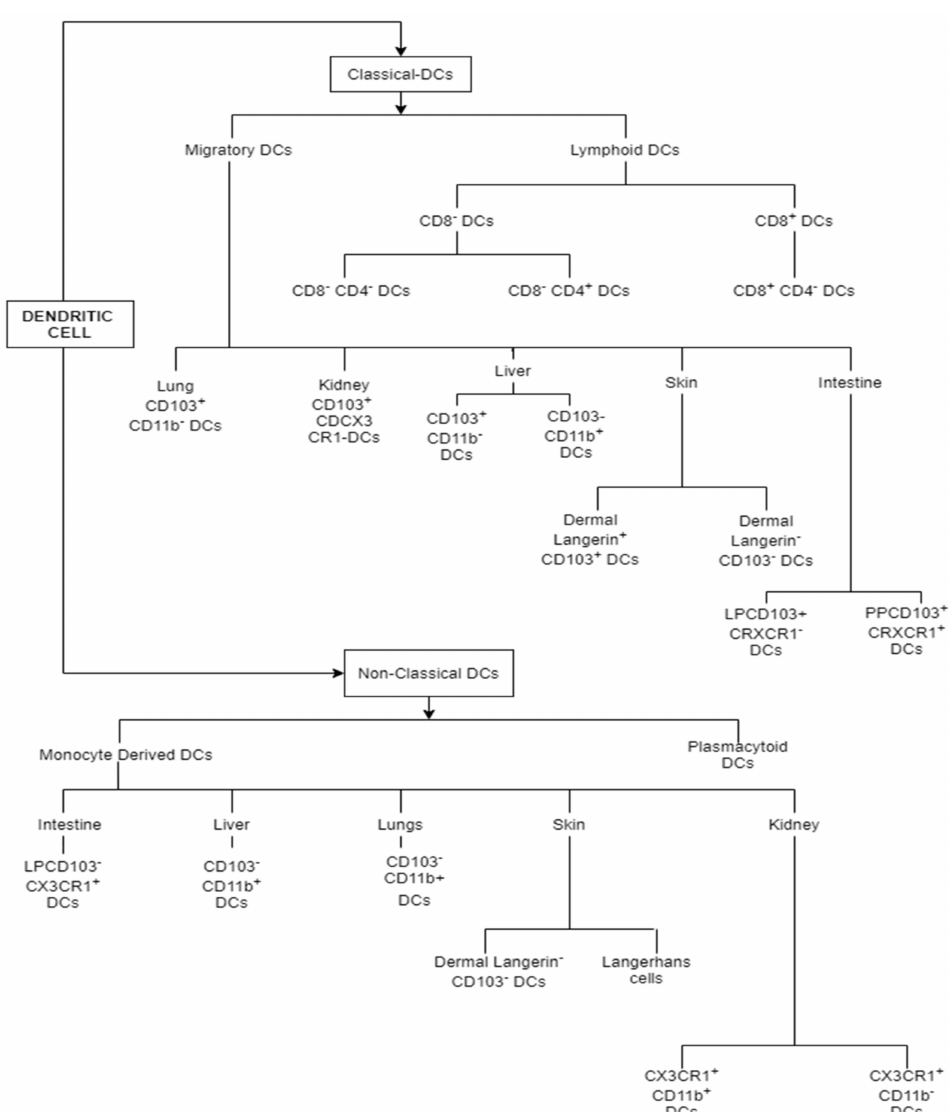
Figure 1. Classification of dendritic cell (DC) subsets as classical and non-classical